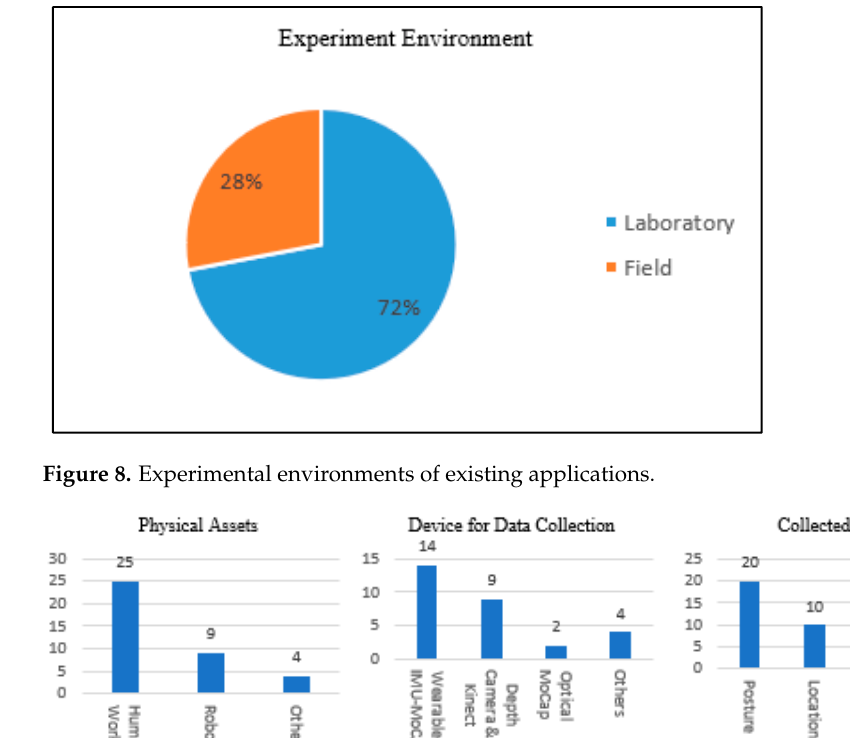
Figure 8. Experimental environments of existing applications.